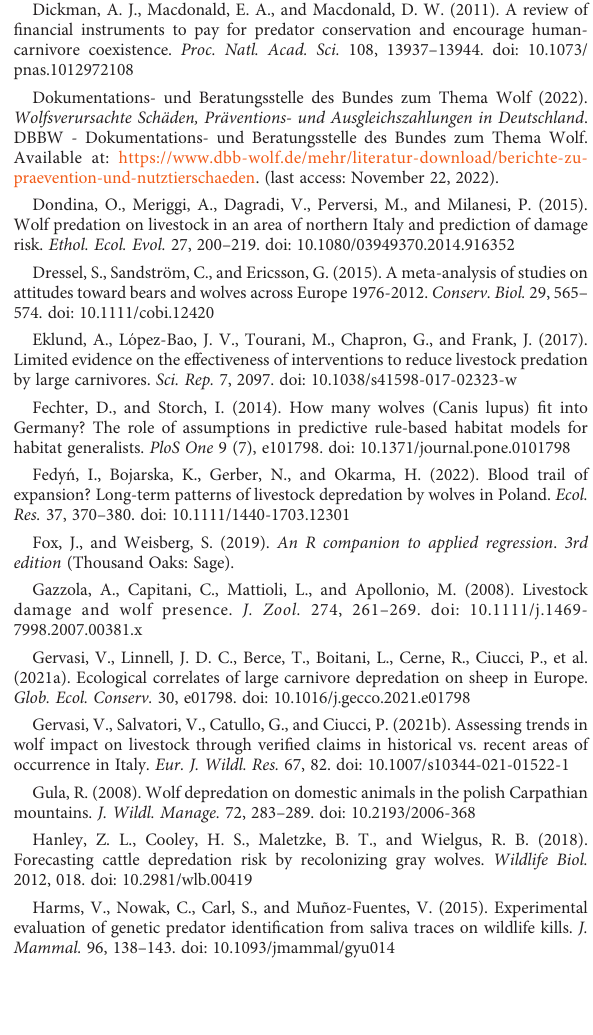
SUPPLEMENTARY FIGURE 2 Rootogram of the fi tted negative binomial regression model to assess the in fl uence of farm type and livestock species category on the number of killed livestock individuals per reported event. Bars indicate observed and red dots indicate expected (given by the model) values. If the bar of the observed values is above the zero line the model overpredicts this particular count bin; if the bar exceeds the zero line it underpredicts the number of predation events. SUPPLEMENTARY FIGURE 3 Rootograms of the fi tted count regression models to predict temporal trends of reported livestock predation events caused by wolves in Brandenburg State (Germany). Bars indicate observed and red dots indicate expected (given by the model) values. If the bar of the observed values is above the zero line the model overpredicts this particular count bin; if the bar exceeds the zero line it underpredicts the number of predation events. Models were fi tted with negative binomial error distribution for sheep and cattle, and with Poisson error distribution for farmed deer and other